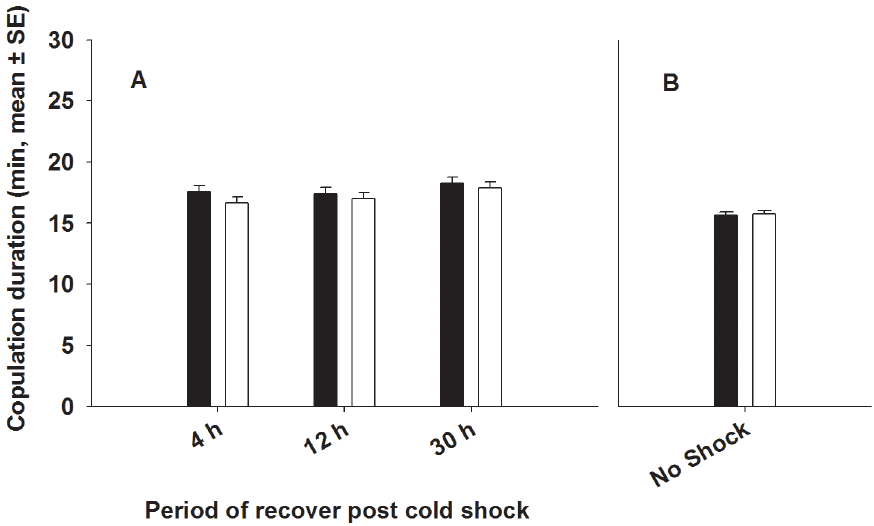
Fig 2. Effect of cold shock (A) or no shock (B) on copulation duration . (A) We assayed copulation duration 4 h, 12 h and 30 h post cold shock. Closed bars represent FCB and open bars represent FSB populations. Selection, period and Selection × period had no significant effect on copulation duration. (B) Under no-shock treatment, there was no significant difference in copulation duration between FSB and FCB males.